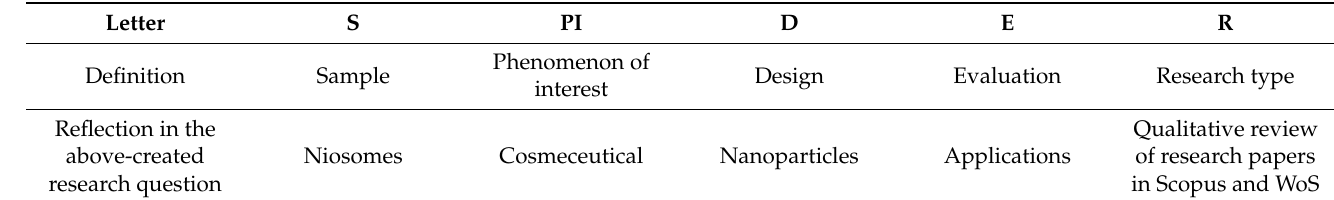
Table 1. Design of the research question for the current systematic literature review.